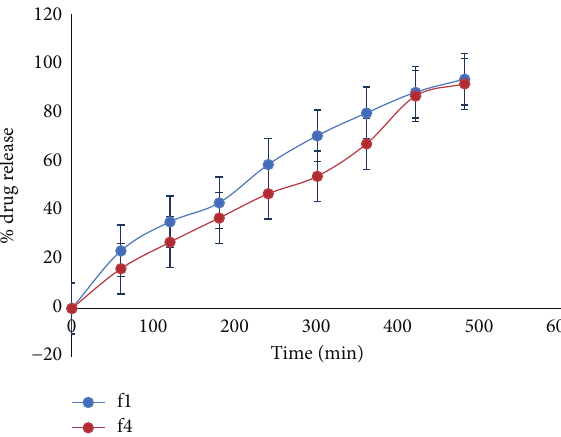
Figure 7: % drug release of formulations f1 and f4.